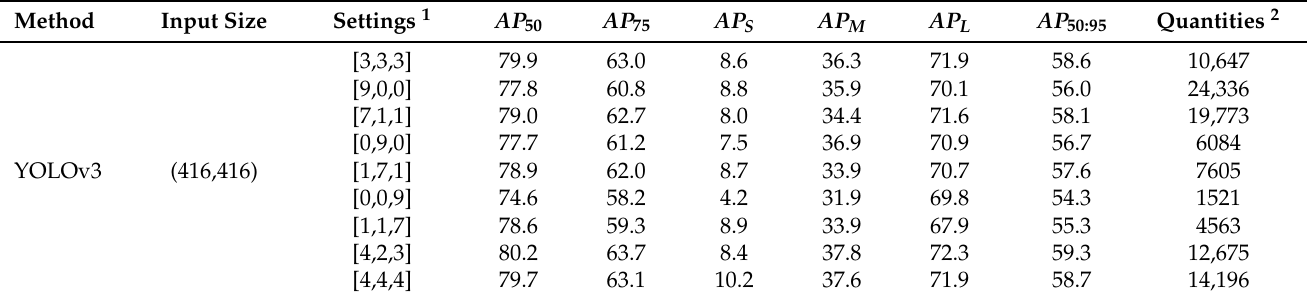
Table 3. Experiment results under different anchor settings on the DIOR dataset.